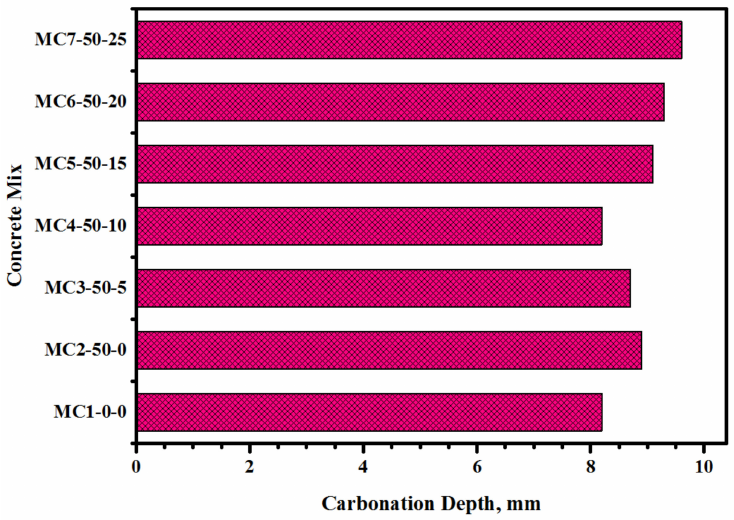
Figure 9. EM solution content-dependent CD of the bio-concrete